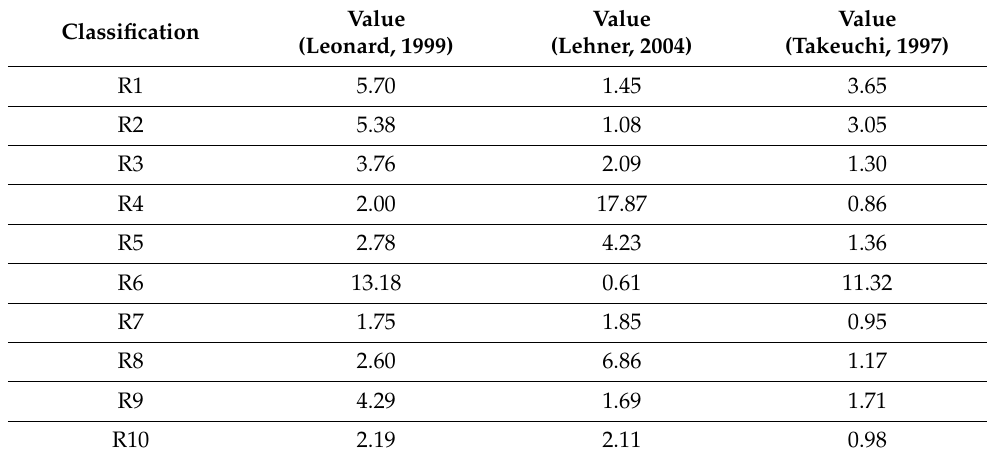
Table 6. Analysis of the results of reservoir morphological characteristics.